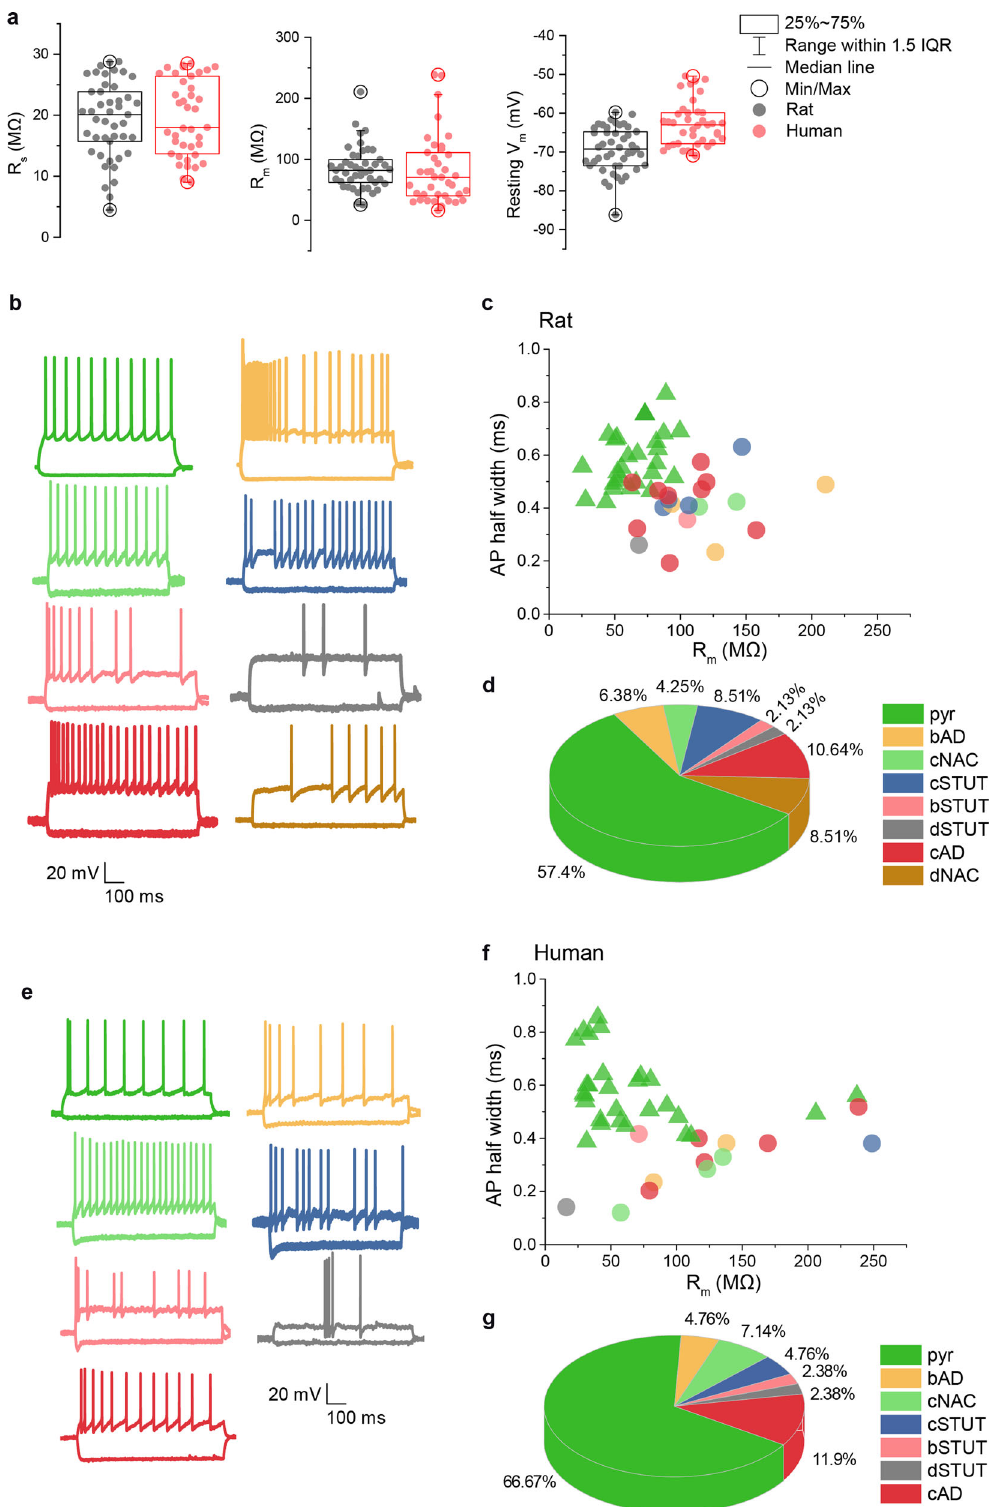
(Fig. 7a, Supplementary Information: Anatomical reconstruc- tion